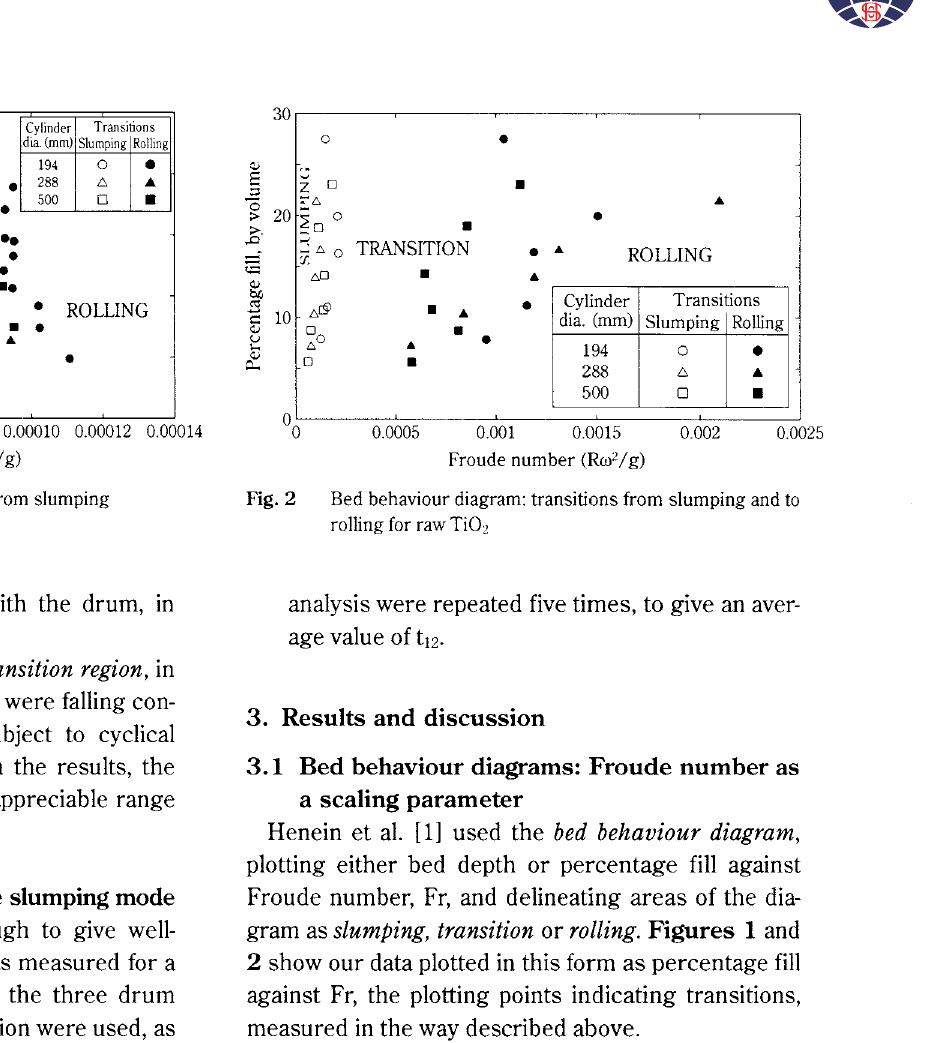
main part of the bed moved with the drum, in